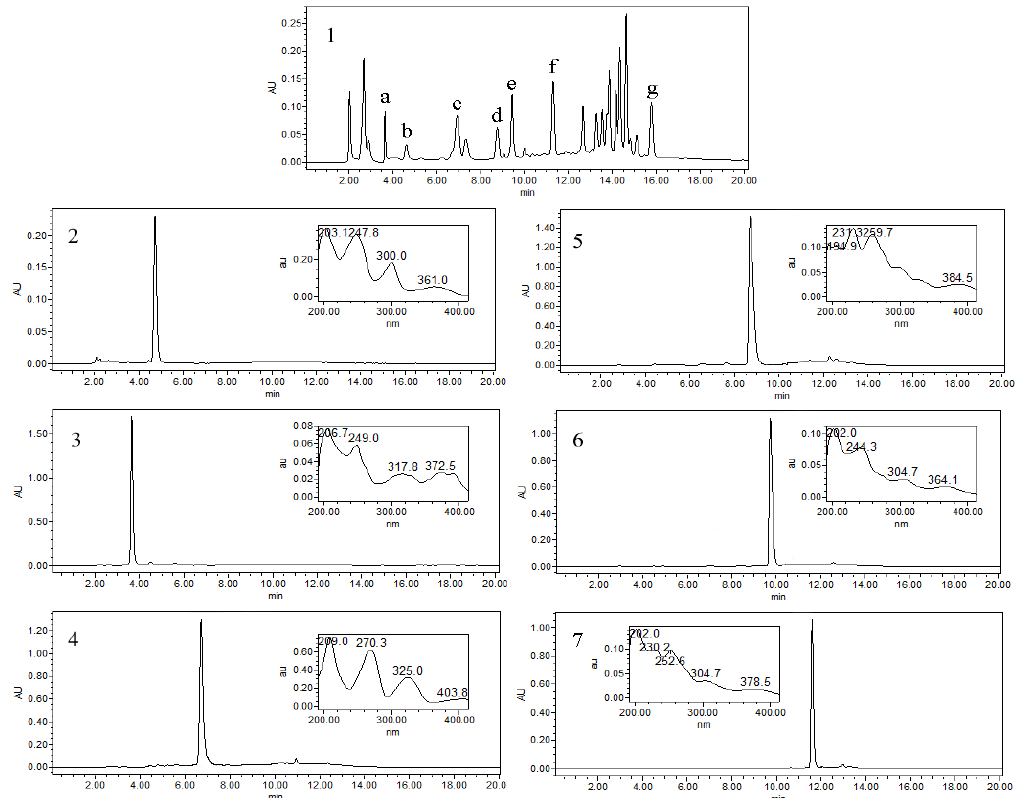
Figure 4. HPLC chromatograms: ( 1 ) Crude extracts from Picrasma quassioides